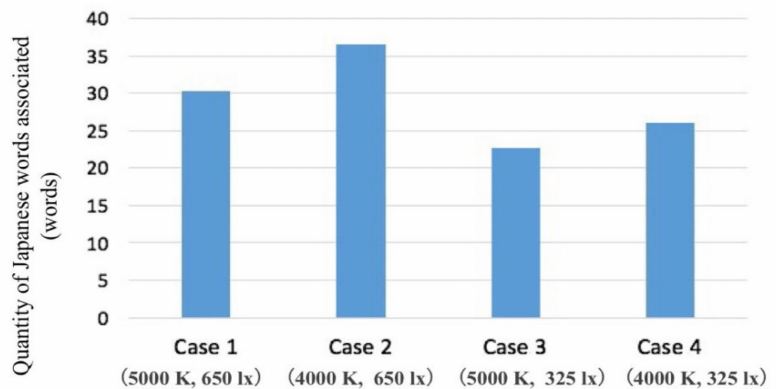
Figure 3. Average quantity of associated Japanese words in di ff erent illumination environments.